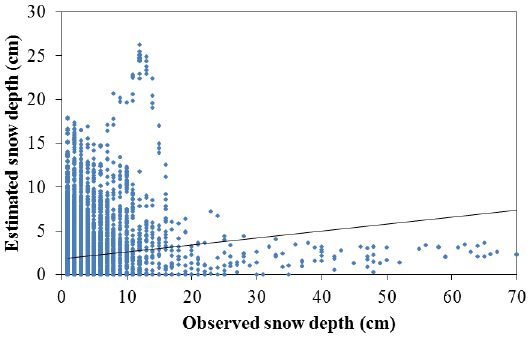
Figure 5. Scatter plot of snow depths observed at meteorological stations and those derived from the AMSR-E from 2003 to 2007.